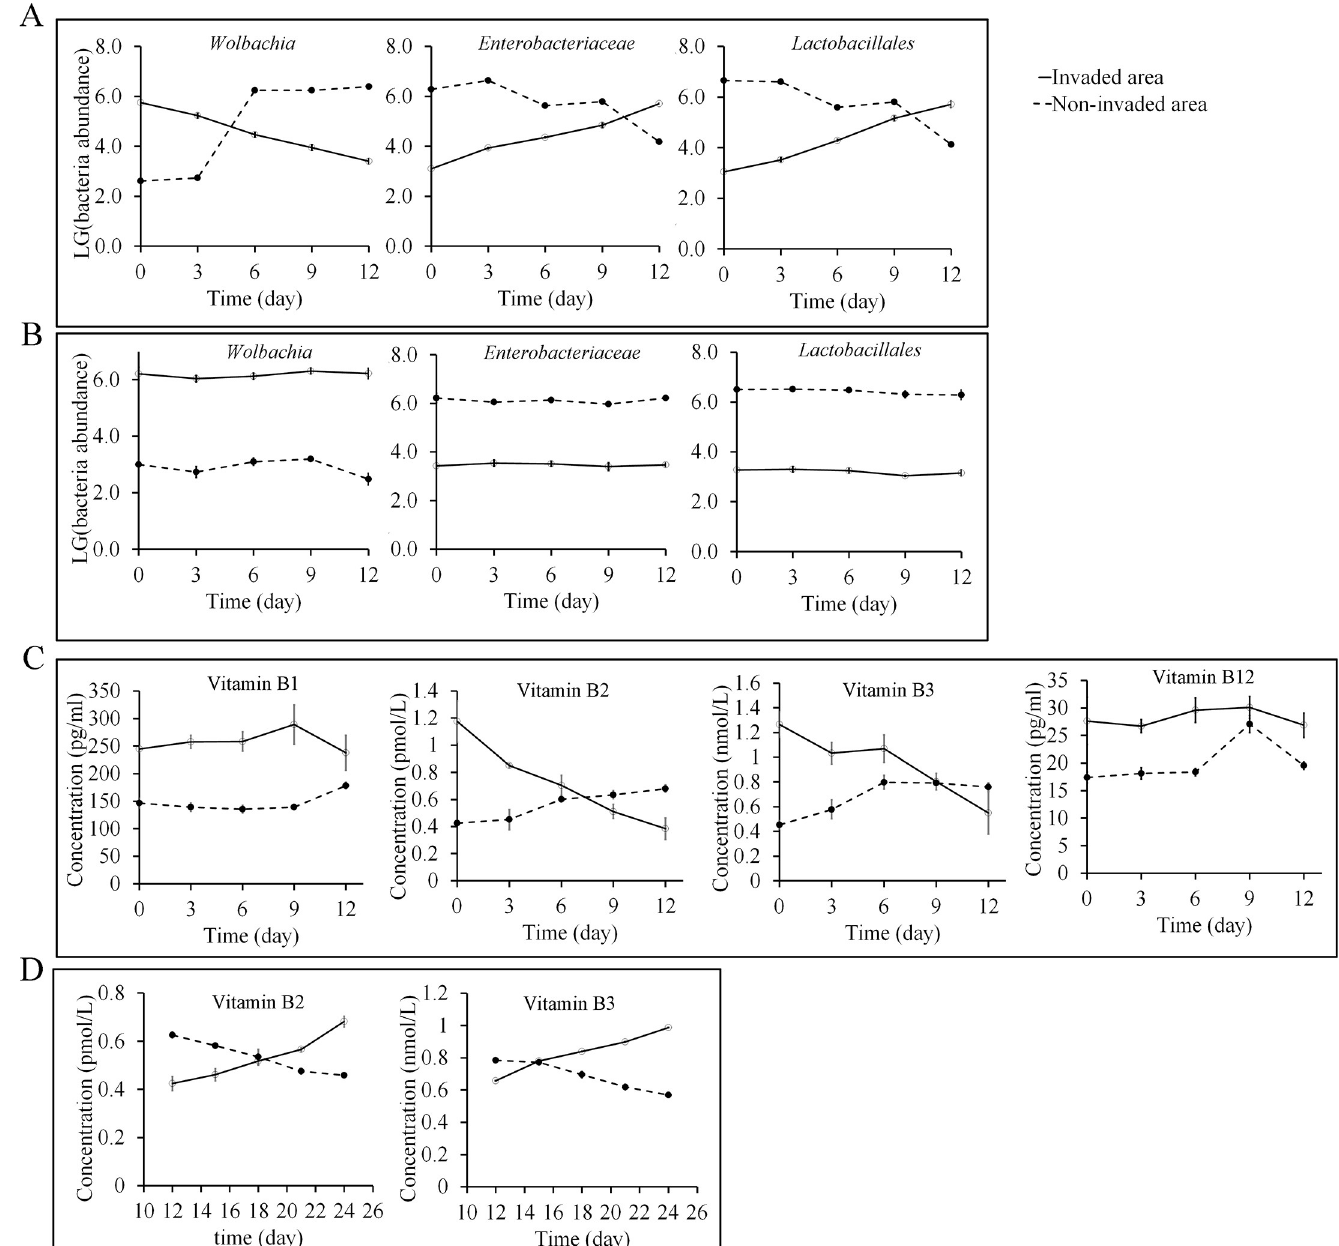
Fig 5. Relative abundances of Wolbachia , Lactobacillales and Enterobacteriaceae and vitamin B concentration in workers of T . melanocephalum . (A) A shift in abundances of Wolbachia , Lactobacillales and Enterobacteriaceae in T . melanocephalum workers from invaded versus non-invaded areas occurs when dietary composition is shifted to sugar (carbohydrate) or locusts (protein) respectively. (B) No shift in abundances of Wolbachia , Lactobacillales and Enterobacteriaceae in T . melanocephalum workers from invaded versus non-invaded areas occurs when diet is not changed in protein or sugar content, respectively. (C) Vitamin B concentration in T . melanocephalum workers from S . invicta invaded and non-invaded areas after supplying with sugar and locusts as food, respectively. (D) Vitamin B concentration in T . melanocephalum workers supplied with complementary food (e.g. peptone or sugar for ants from S . invicta invaded areas and non-invaded areas, respectively) (as follow-up experiment to (C)). ‘LG’ (on the y-axis) stands for logarithm to the base of 10.